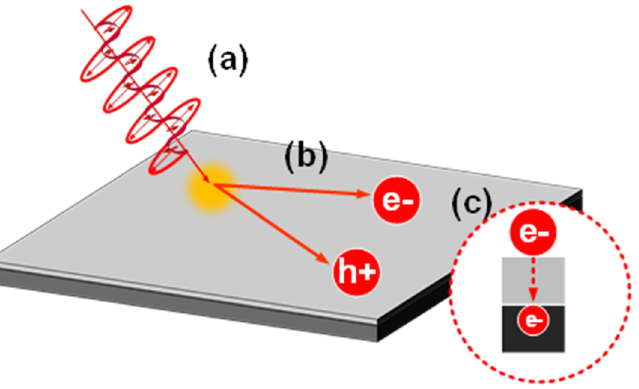
Figure 8. ( a ) The generation of surface plasmon by irradiating light on the metal surface. ( b ) The generation of hot electrons and hot holes during the decay of the surface plasma. ( c ) The decay of the generated hot carriers with time.